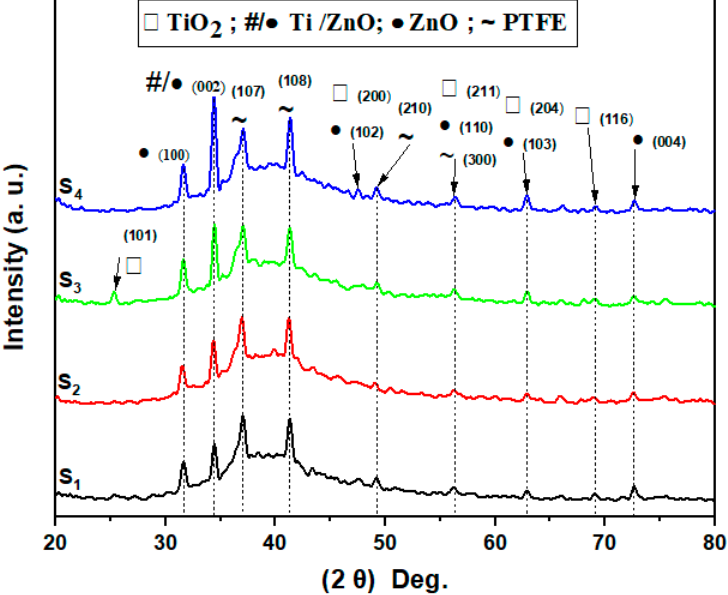
Figure 5. XRD patterns for samples S1, S2, S3, and